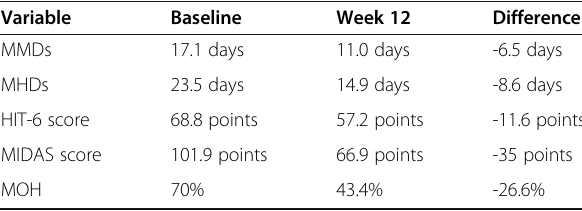
Table 1 Clinical responses and patient-reported outcomes (PROs) at the baseline period and after week 12 of erenumab